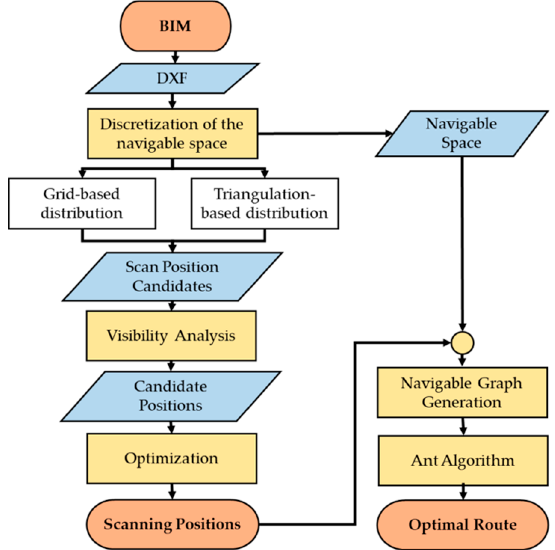
Figure 1. General workflow of the method.